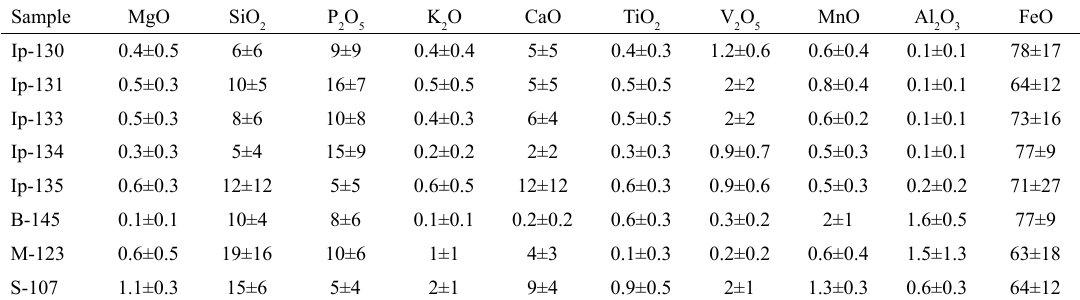
Figure 1: Typical microstructure of slag inclusions, featuring the presence of dendrites of wüstite, BEI, SEM: (a) Ipanema (Ip-135 sample); (b) Bahia (sample B-45); (c) Missions (M-123 sample); (d) Sardinha (S-107 sample). Table 2: Average EDX microanalysis results of the “entire” multiphase slag inclusions.